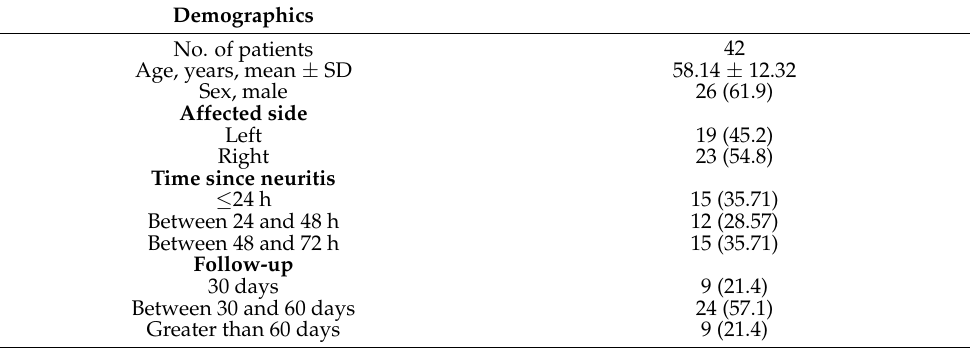
Table 1. Clinical characteristics of the VN population.